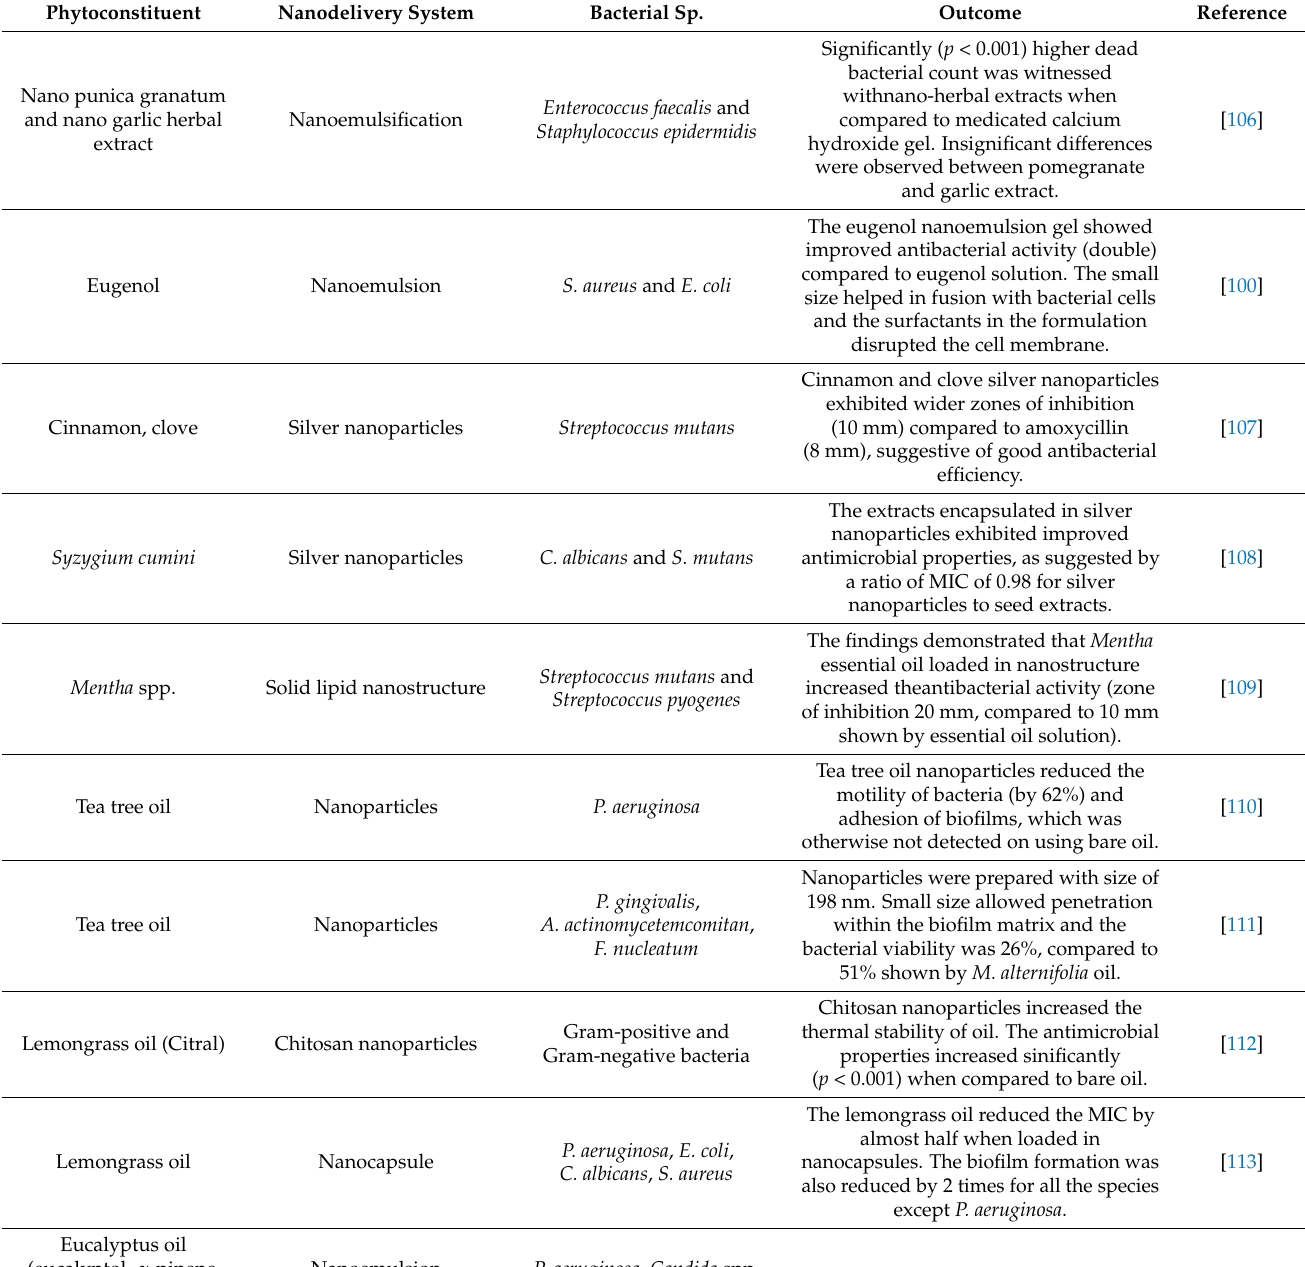
Table 3. Nanodelivery systems of phytoconstituents and their role in microbial biofilm